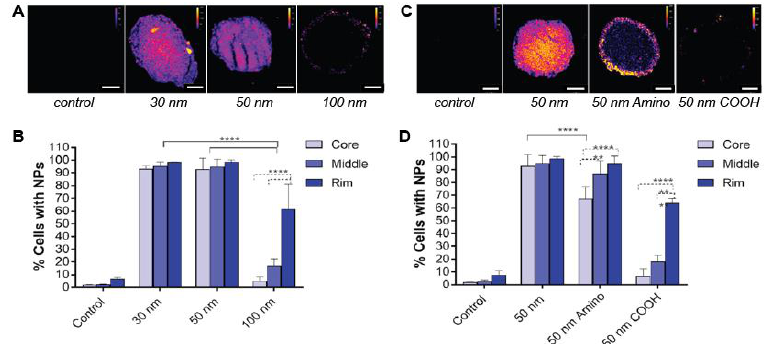
Figure 2. The effect of nanoparticle size ( A , B ) and charge ( C , D ) on penetration depth in spheroids. ( A ) Confocal images of 20 µm frozen sections of HCT116 spheroids after 24 h incubation with 30, 50 and 100 nm polystyrene nanoparticles. Scale bar: 100 µm. ( B ) The distribution of the different sized particles (30, 50 and 100 nm) across the spheroid, distinguishing the core, middle and rim. ( C ) Confocal images of 20 µm frozen sections of HCT116 spheroids after incubation with 50 nm polystyrene nanoparticles (unmodified, aminated and carboxylated polystyrene nanoparticles). Scale bar: 100 µm. ( D ) The distribution of the 50 nm particles with different surfaces (unmodified, aminated and carboxylated) across the spheroid, distinguishing the core, middle and rim (****, ** and * indicate p < 0.0001, p < 0.01 and p < 0.05, respectively). Adapted from Reference [37], with permission